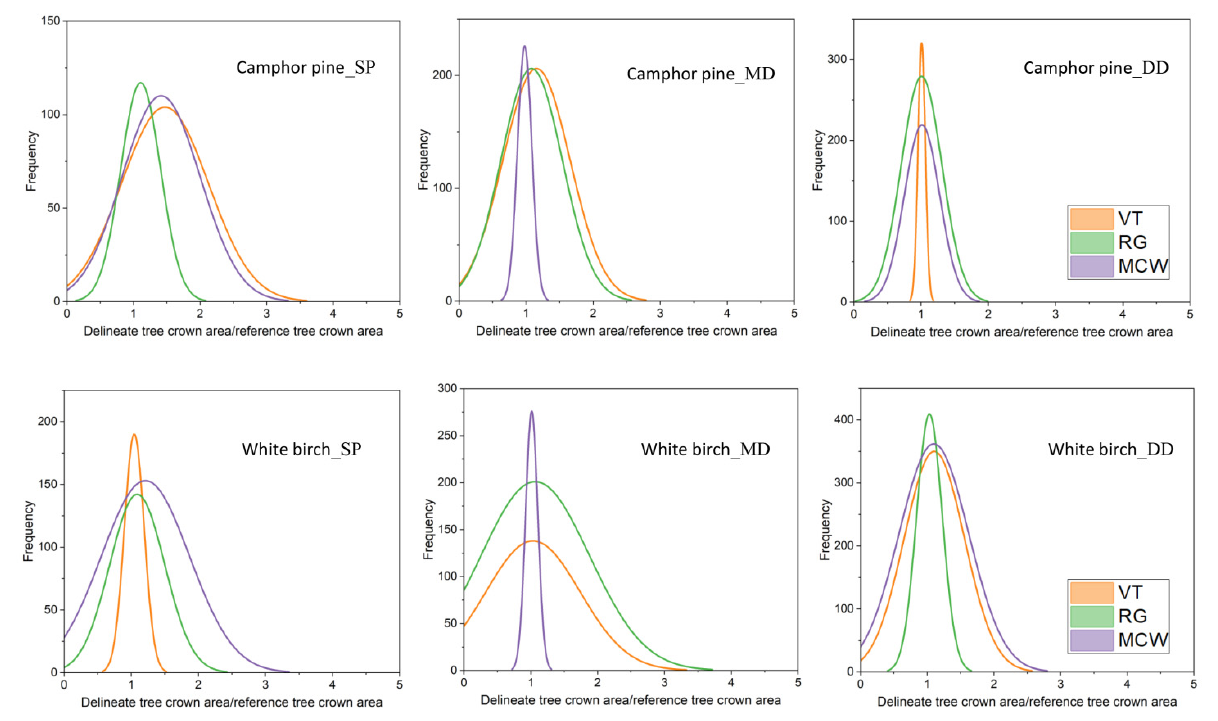
Table 2. The matched conditions of tree-crown results obtained by different crown-contour algo- rithms with reference-crown results among various scenarios.